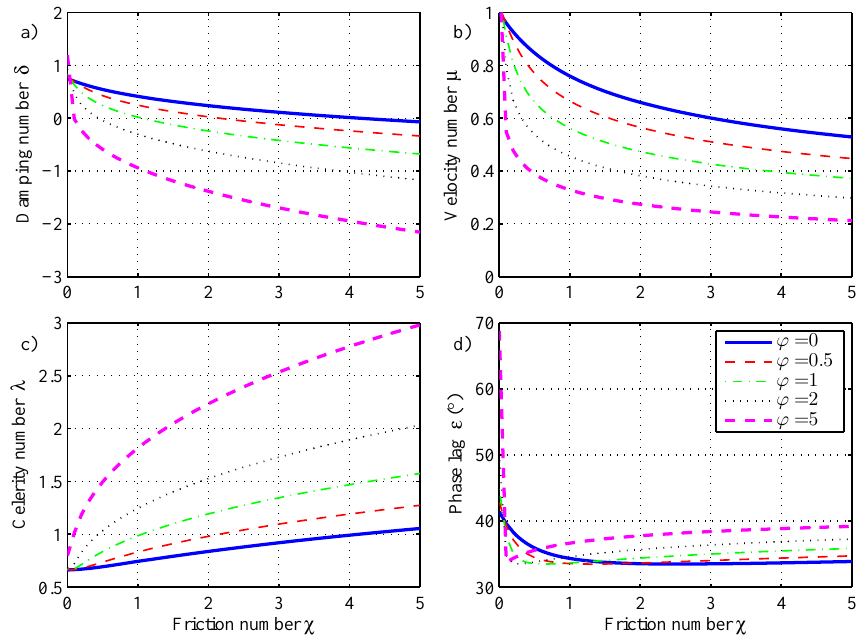
Fig. 5. Relationship between the main dimensionless parameters and the friction number χ obtained by solving Eqs. (11) (with 0 = 0 H ), (30) and (31) for different values of the dimensionless river discharge term ϕ with ζ 0 =0.1, γ =1.5 and r S